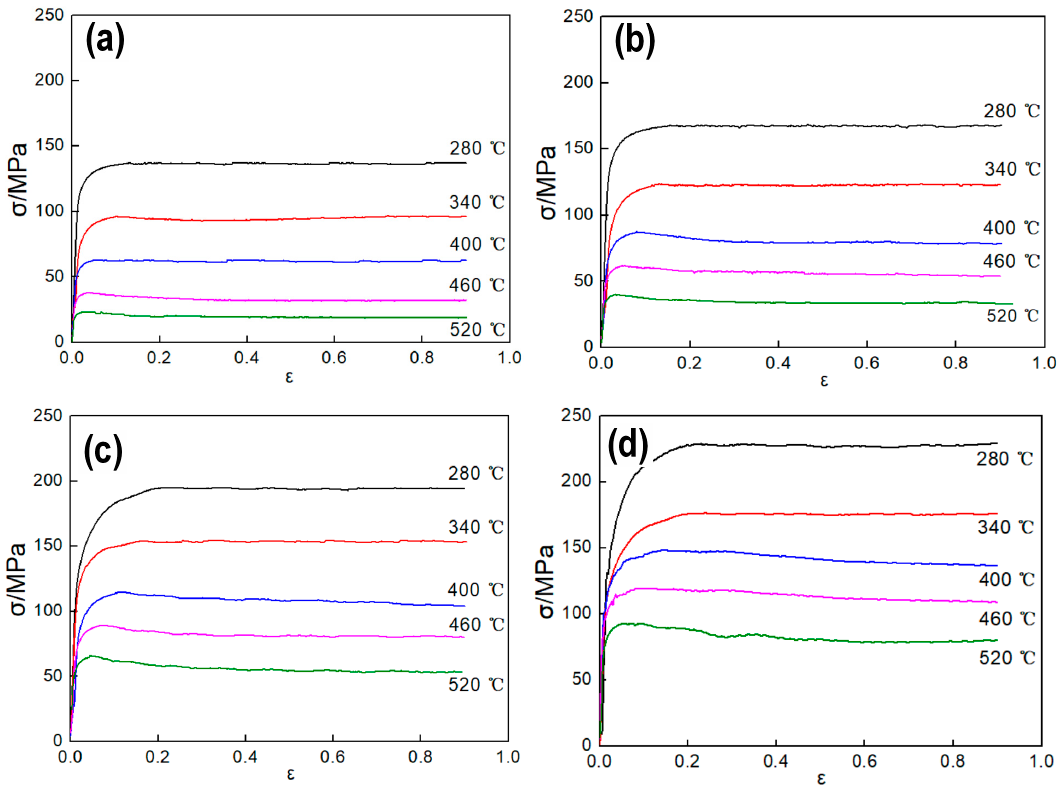
Figure 2. The true stress–strain curves under various strain rates: ( a ) 0.01 s − 1 , ( b ) 0.1 s − 1 , ( c ) 1 s − 1 , ( d ) 10 s − 1 .